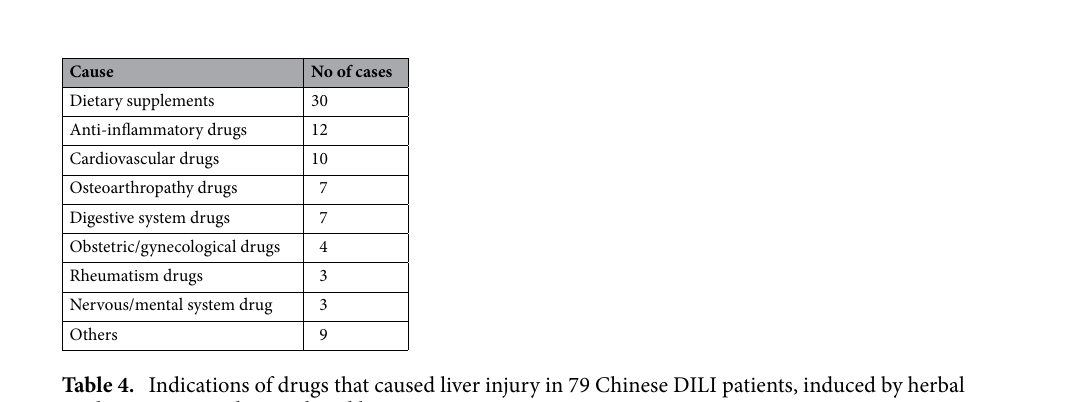
Table 3. Therapeutic classes of drugs that caused liver injury in 164 Chinese patients.